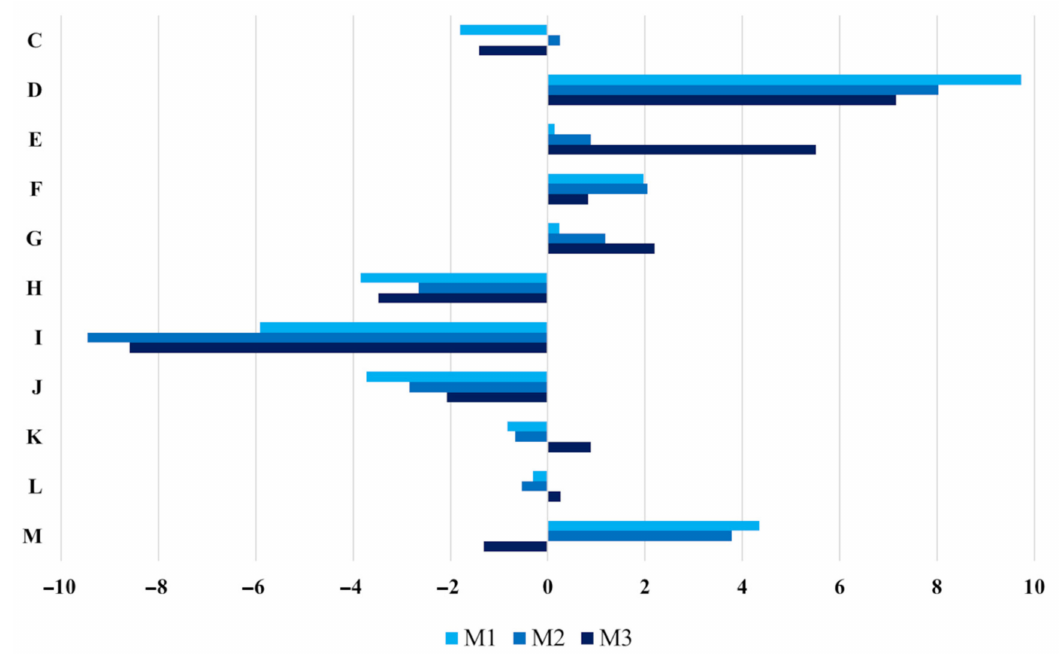
Figure 5. Differences between percentage of tweets and percentage of population (by NUTS and by